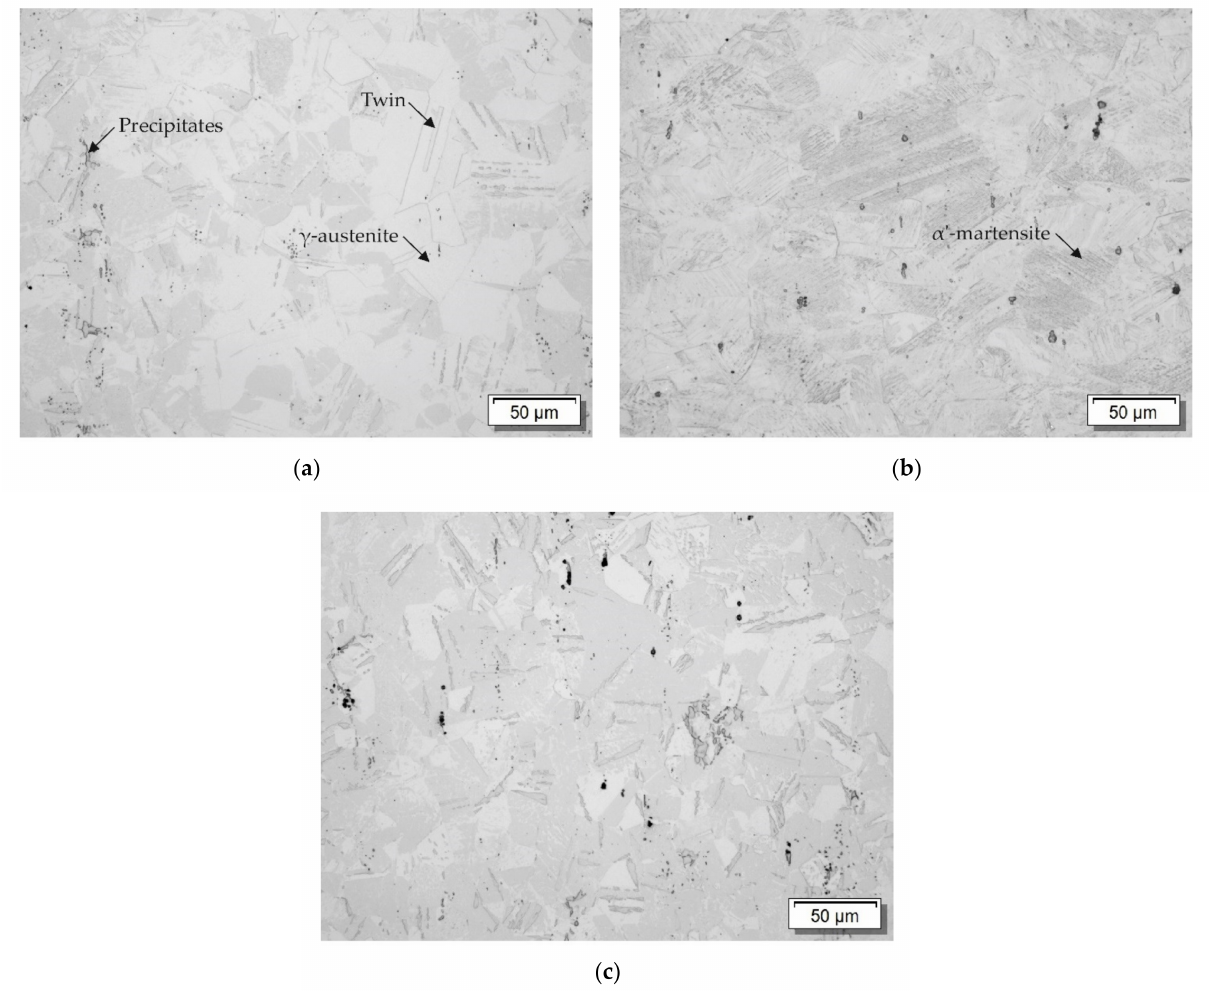
Figure 5. Microstructure of specimens investigated in the preliminary tests: ( a ) as-cut; ( b ) pre-deformed to a total strain of 28%; ( c ) pre-deformed to a total strain of 28% and heat-treated in accordance with a conductive brazing temperature